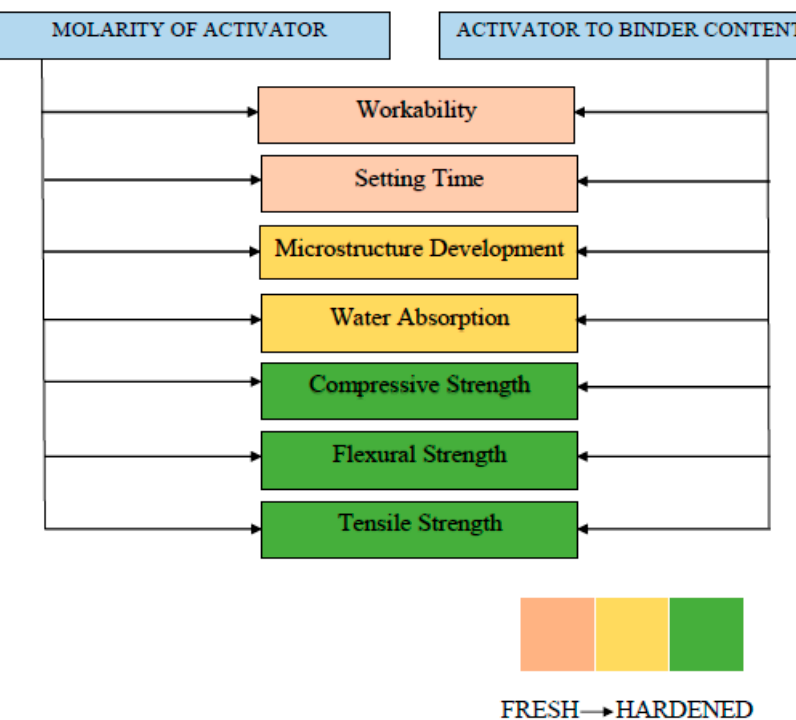
Figure 30. Fresh and hardened properties considered while determining activator to binder content and molarity.